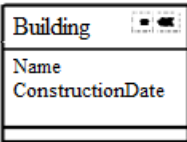
Figure 11. Example of fuzzy multiple